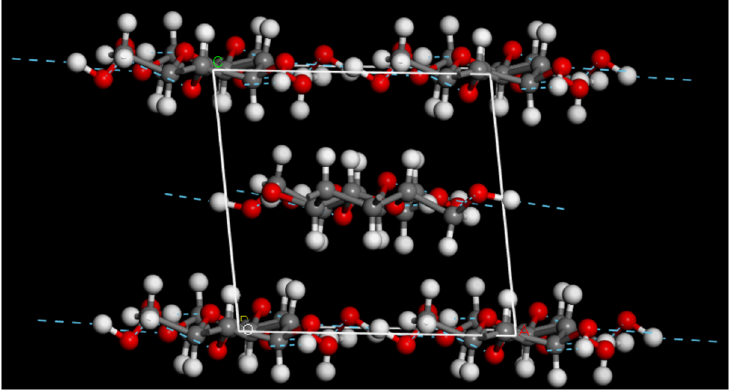
Figure 1. Unit cell of crystalline cellulose I β . The unit cell vectors are drawn in white. Next, we cut cellulose fibrils from the bulk cellulose by cleaving the crystal in such way that the fibrils had either 7, 10, or 14 cellulose chains. The fibril model remained pe- riodic in one direction, and a supercell three times the original unit cell size was created in this direction. The resulting one-dimensional fibril models are illustrated Figure 2.